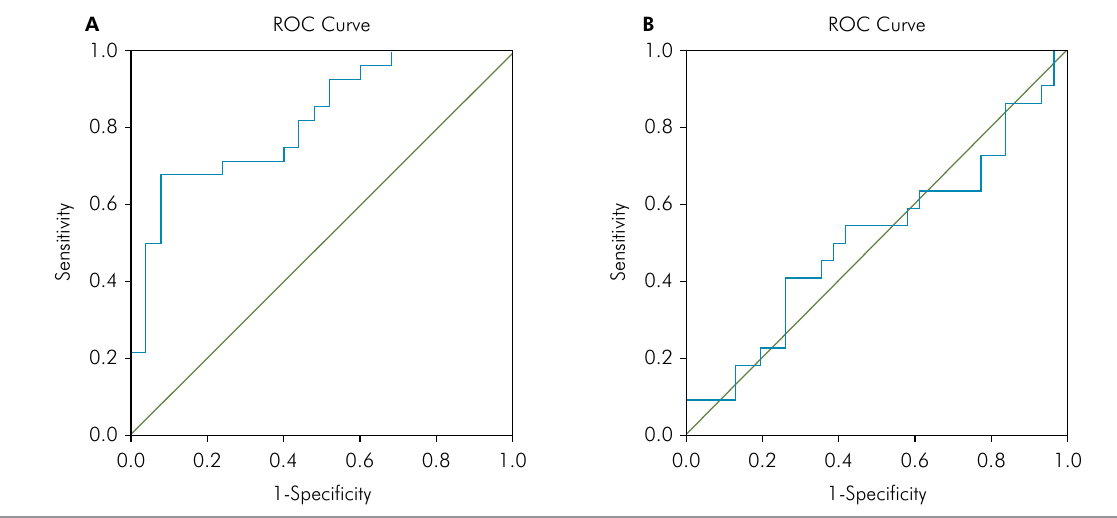
Figure 5. A: ROC curve for miRNA-21; B: ROC curve for